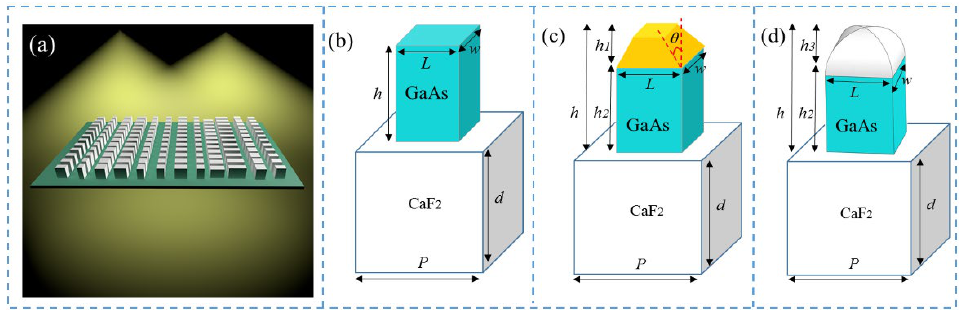
Figure 1. ( a ) Schematic of the metalens based on GaAs nano-bricks with different lengths and widths at the wavelength of 4.2 µ m, with the incidence from substrate to free space. ( b ) Unit-cell of the proposed structure. The geometrical parameters were set as P = 1.8 µ m, and h = 3.6 µ m. Isosceles trapezoidal platform ( c ) and smooth elliptical hemisphere ( d ) on the top of GaAs nano-bricks, seaming completely with the rectangular brick.